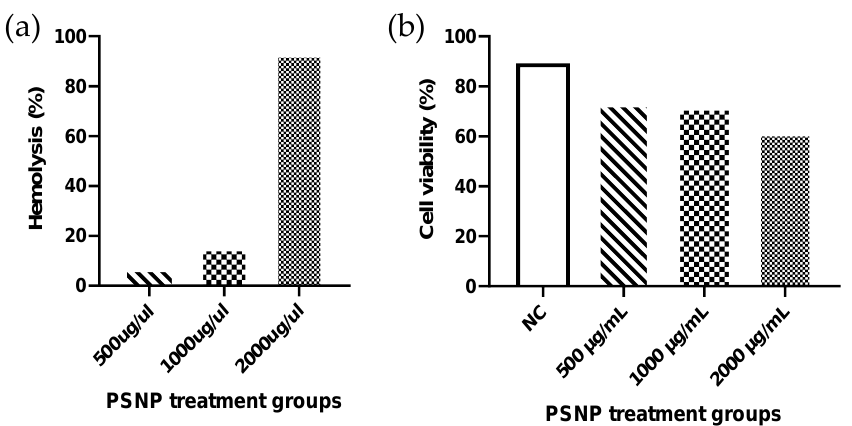
Figure 1. Percentage hemolysis ( a ) and cell viability ( b ) of lymphocyte cells treated with different concentrations of PSNP.